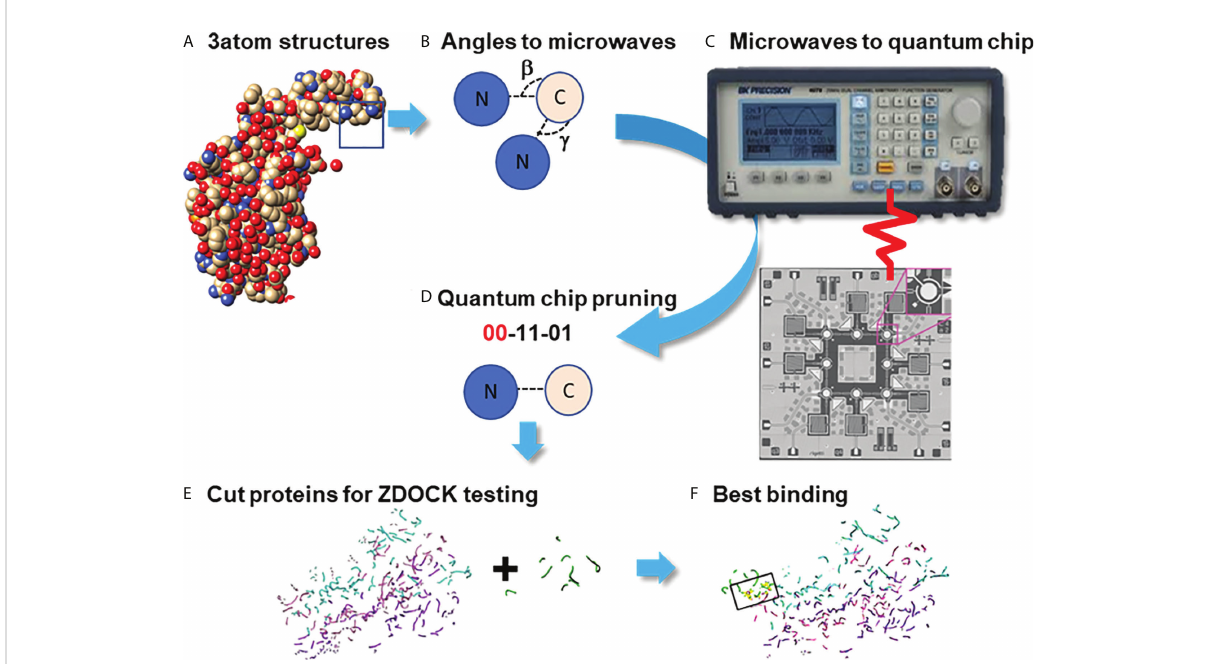
FIGURE 2 Pruning Program by utilizing the Quantum Approximate Optimization Algorithm (QAOA) on the Rigetti Quantum Processor. Process diagram for fi nding protein binding by Pruning. (A) Create graphs of 3 neighboring atoms each, with angles beta and gamma stored (B) Fourier-transform angles into frequencies to be placed on quantum chip by microwave. (C) Send microwaves to quantum chip. (D) Read results from quantum chip to determine which atoms to cut, with 00=Cut. (E) Summation of cut atom graphs to build reduced structures. (F) Binding studies between reduced structures with ZDOCK testing to identify the best binding